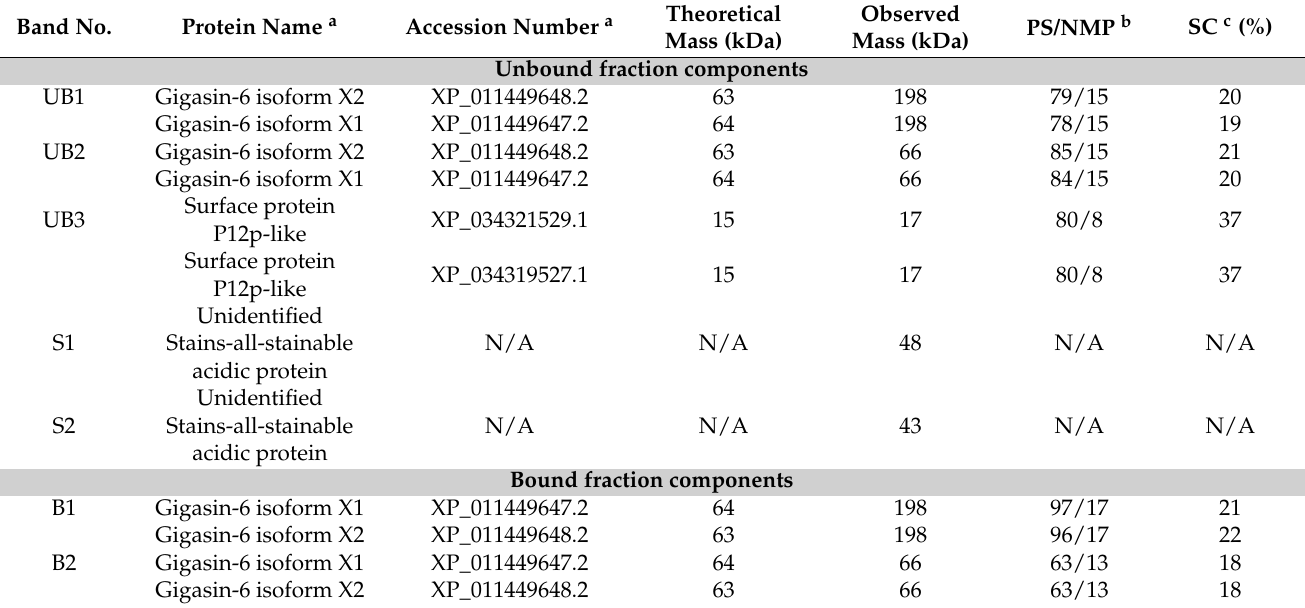
a Protein name and accession number according to NCBI database, b Protein score (PS) and the number of matched peptides (NMP) obtained from Mascot search, c Percentage of sequence coverage of identified peptides related to the corresponding sequence in the